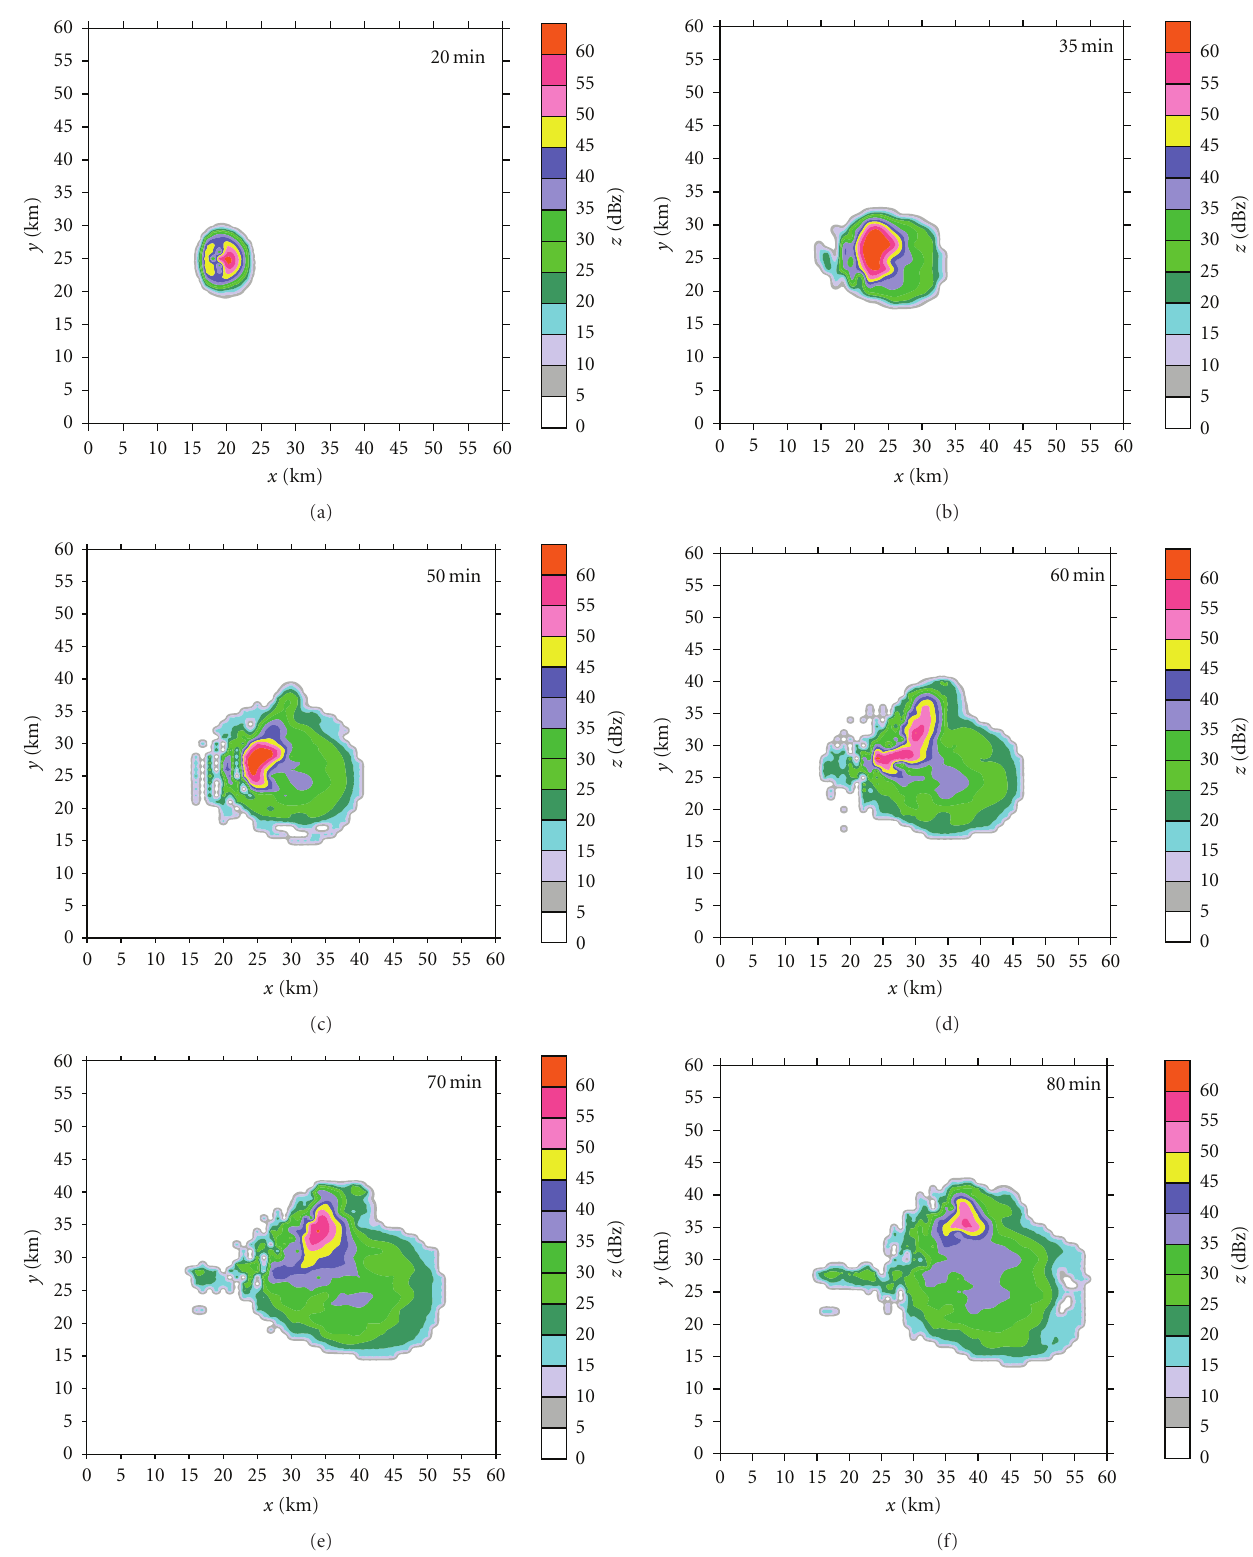
Figure 8: Horizontal cross-section of radar reflectivity (dBz) at z = 6 . 5kmm.s.l. Model results at 20, 35, 50. 60, 70, and 80 minutes of the simulation time. Model run